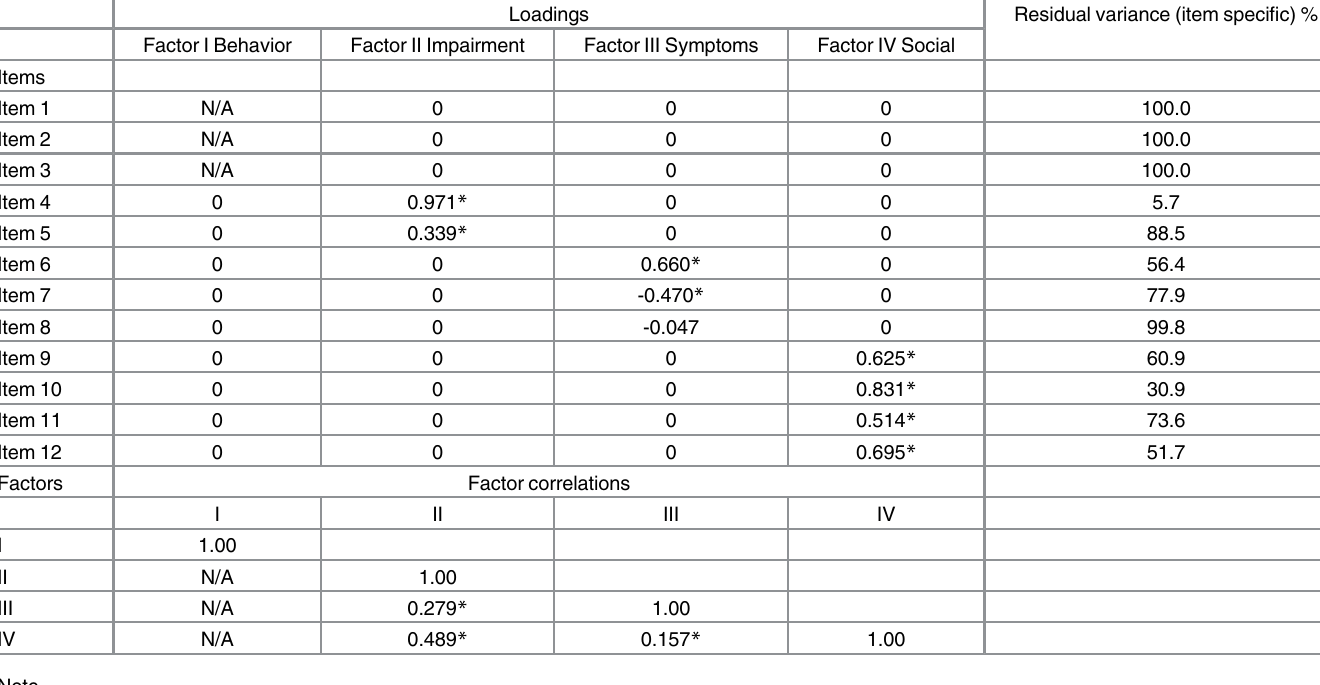
Table 3. Loadings for the four-factor Confirmatory Factor Analysis (N =